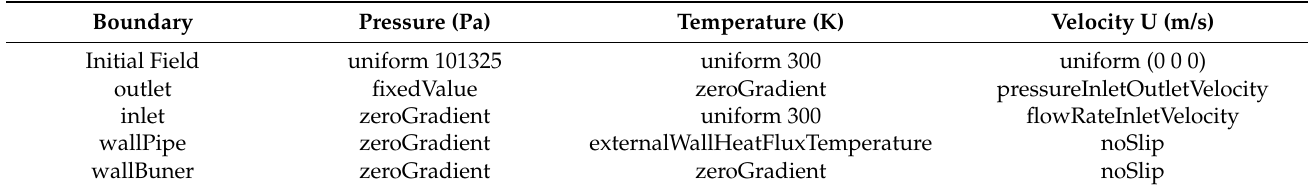
Table 2. Laboratory-scale furnace boundary